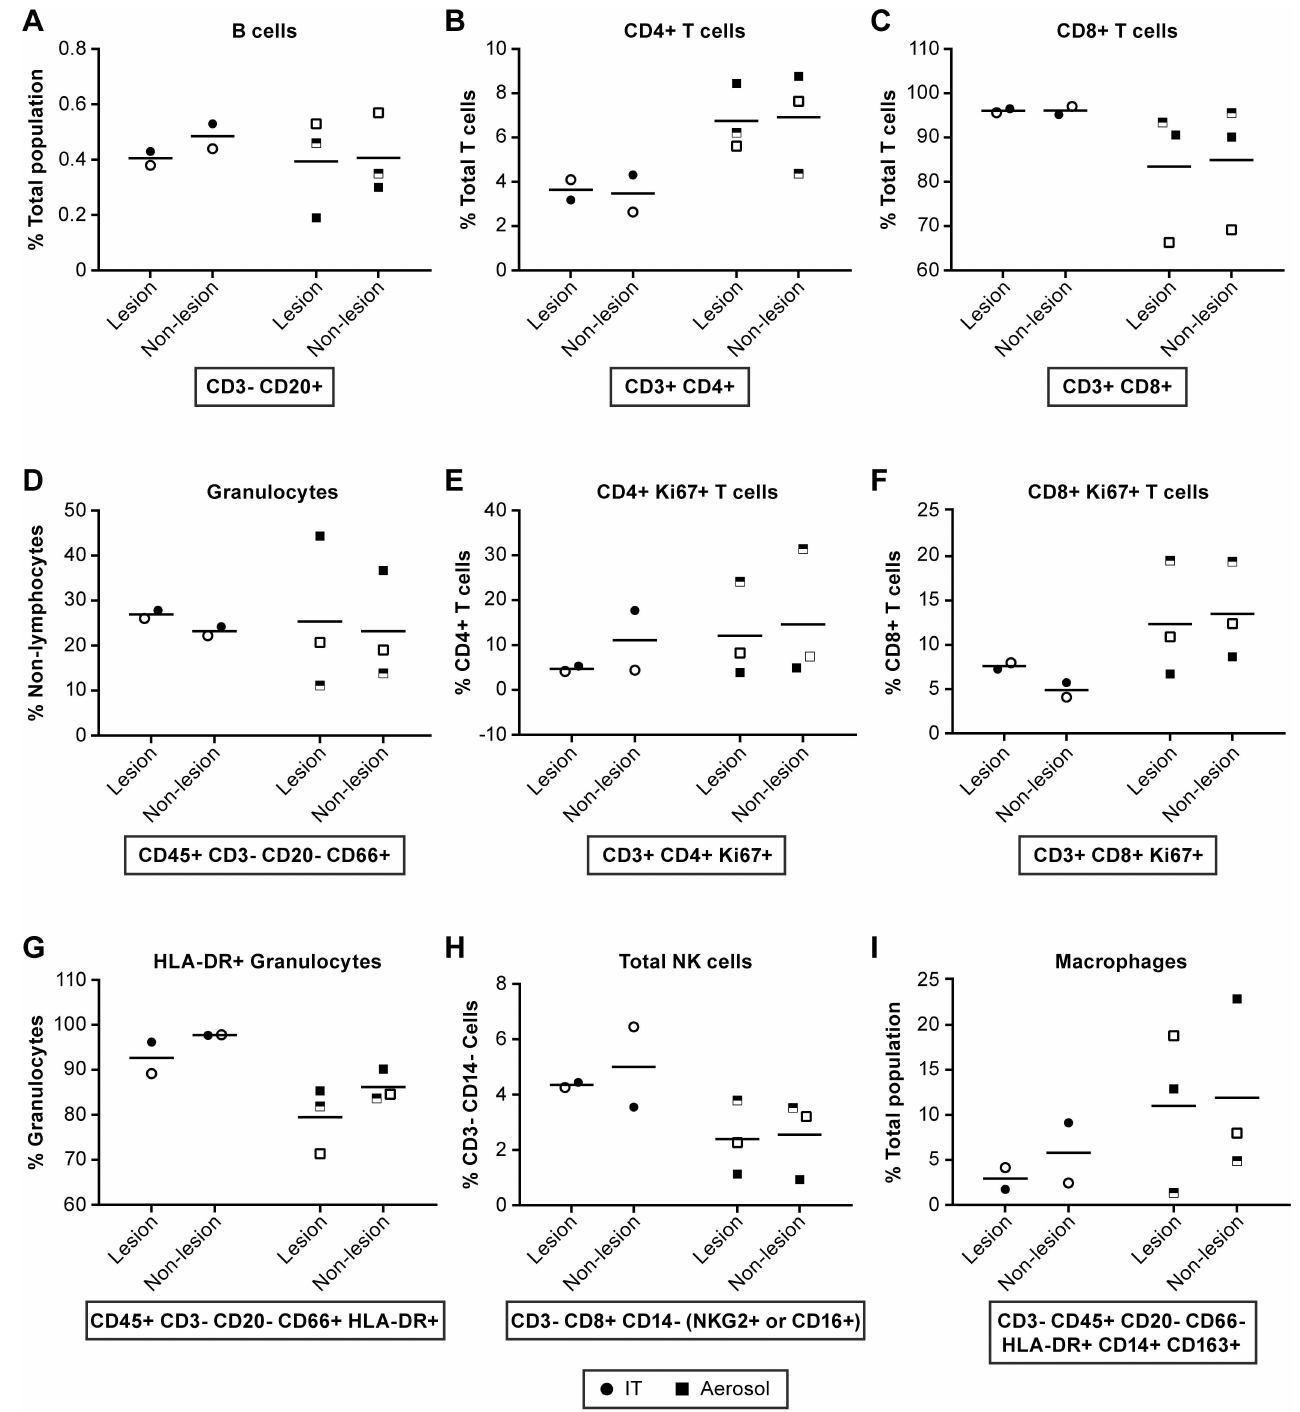
Fig 9. Evaluation of immune cell population in the lung collected at necropsy. Comparisonsof immune cell populationsin “lesion” and “non- lesion”samples collectedat necropsyfrom animalsinfected by IT ( ● ) or aerosol ( ■ ) inoculation.Markers are consistentfor individualanimals. IT inoculated: 8204 ( ● ), 8213 (half-filled (cid:14) ) and 8181 ( (cid:14) ); Aerosol inoculated: 8210 ( □ ), 8095 (half-filled □ ) and 8206 ( ■ ). Represented are data for (A) B cells, (B) CD4+ T cells, (C) CD8+ T cells, (D) Granulocytes, (E) Ki67+ CD4+ T cells, (F) Ki67+ CD8+ T cells, (G) HLA-DR+ Granulocytes, (H) Total NK cells and (I) Macrophages. These data suggest that CD4+ cells are elevated in aerosol inoculated animalsrelative to IT inoculatedwhileactivated granulocytes (HLA-DR+)and NK cells appearsomewhat elevatedin IT inoculated animals. Statistical analyseswere not performed due to limited group